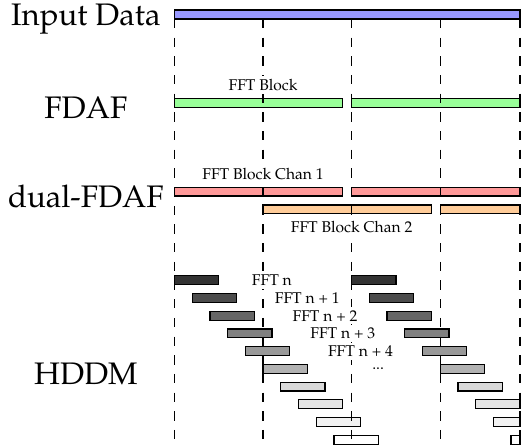
Figure 4. FFT block selection comparison between different